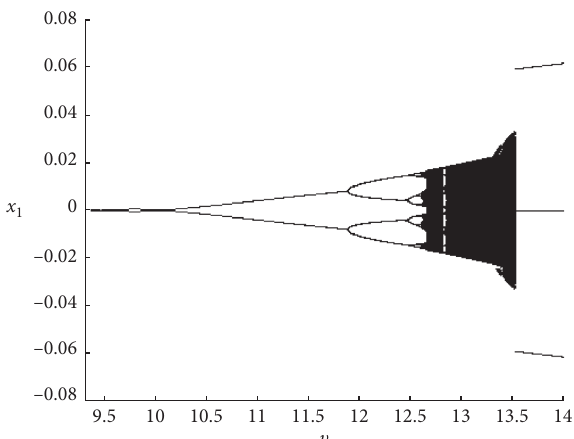
Figure 8: The bifurcation diagram for the nonlinear system of � 1, as υ is Figure 7 with l 0